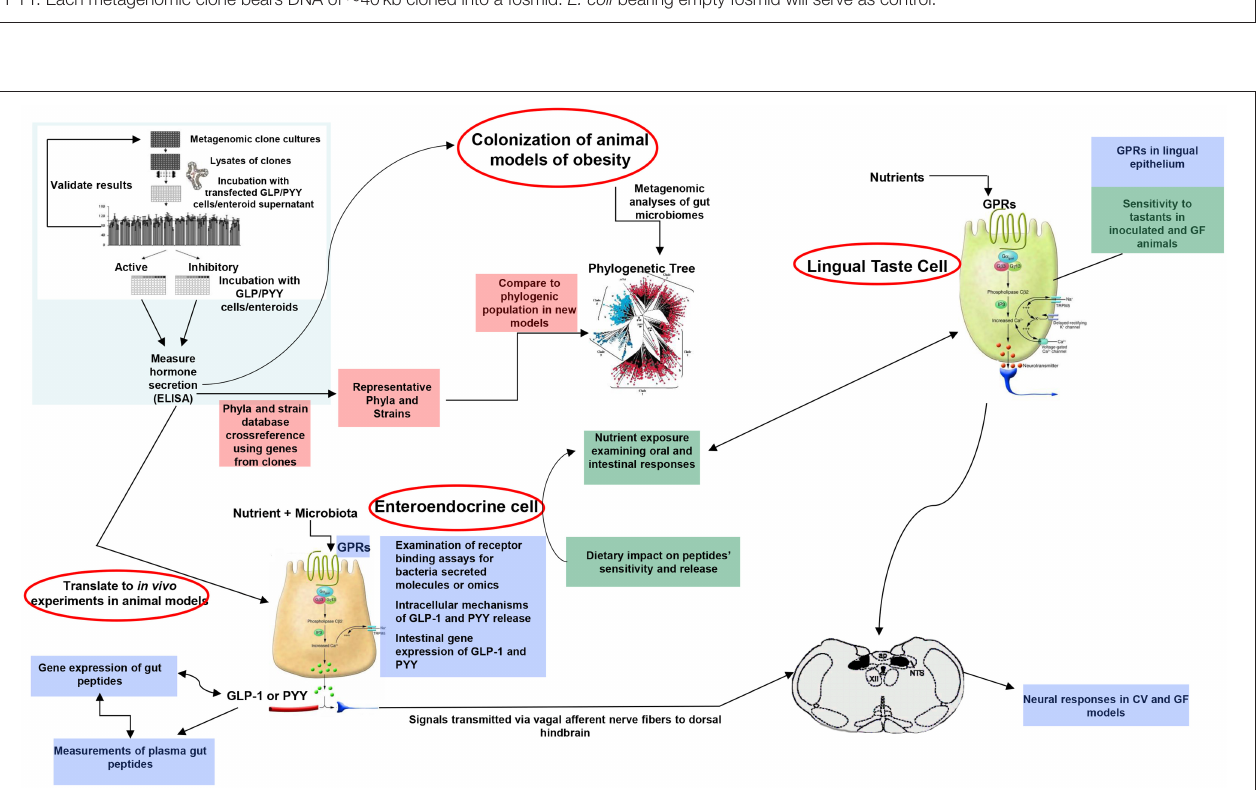
FIGURE 3 | Proposed model of functional metagenomics for studying microbiota-gut peptide interactions. The first step (top left), involves high throughput screening (HTS) of metagenomic libraries to identify candidate clones/bacteria able to stimulate gut peptides (i.e., GLP-1, PYY, CCK) gene expression (using gene reporter technology) and release (following calcium flux) from EEC cultures or enteroids (pink color). The full metagenomic insert of clones of interest is then sequenced to characterize the genes/loci involved using NGS and assign them phylogenetically and functionally. The second step (blue color) represents identification of signaling mechanisms responsible for metagenomic clone-induced-activation of EEC-like cells and gut peptide release. Finally, the effect of identified clones of interest can be tested in obese models for their effects on oral and intestinal contributors to caloric intake, including vagal responses (green color).